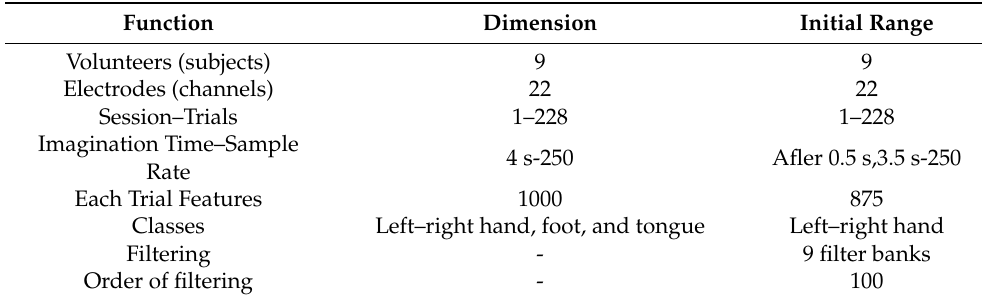
Table 5. The details of data set IIa from BCI competition